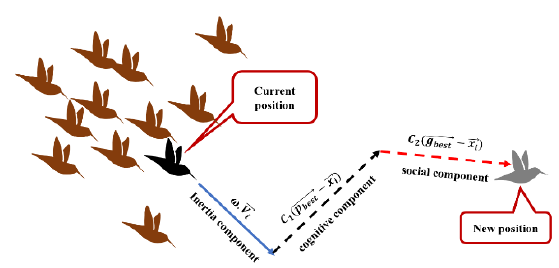
Fig. 8. Principle of the PSO technique.